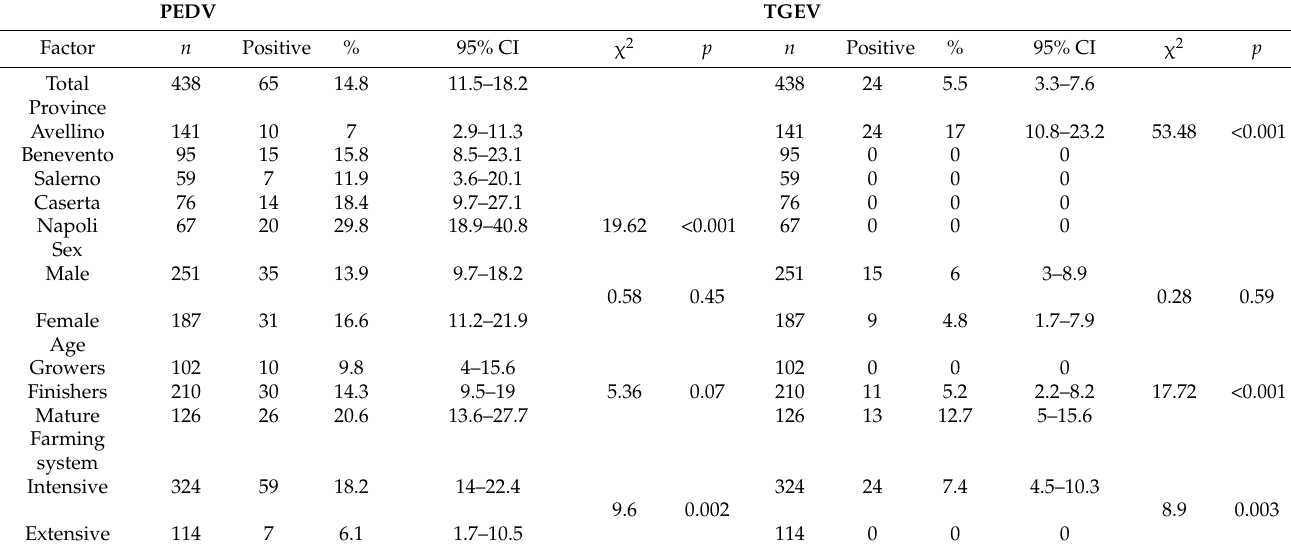
Table 2. Univariate analysis (chi-square) of a potential risk factor for PEDV and TGEV seropositivity.